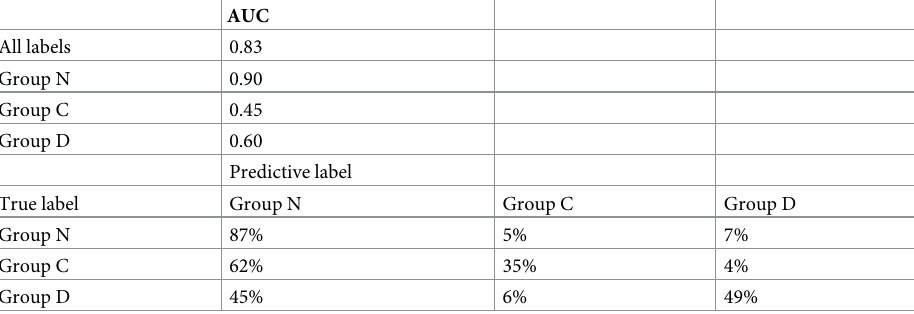
Fig 4. (A) The precision of the Groups N, C and D colon image AI model is plotted as a function of recall. The blue shaded area represents the area under the curve (AUC), and the blue dot indicates the value in the case with a reliability threshold of 0.5. (B) The intersection of the recall (blue line) and the precision (red line) is shown. The blue and red dots indicate the values when the reliability threshold is set to 0.5. https://doi.org/10.1371/journal.pdig.0000058.g004 Table 2. Groups N, C and D model of the colon; AUC and confusion